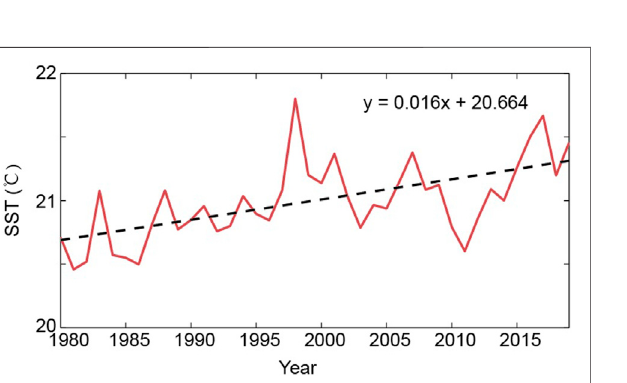
Frontiers in Physics |